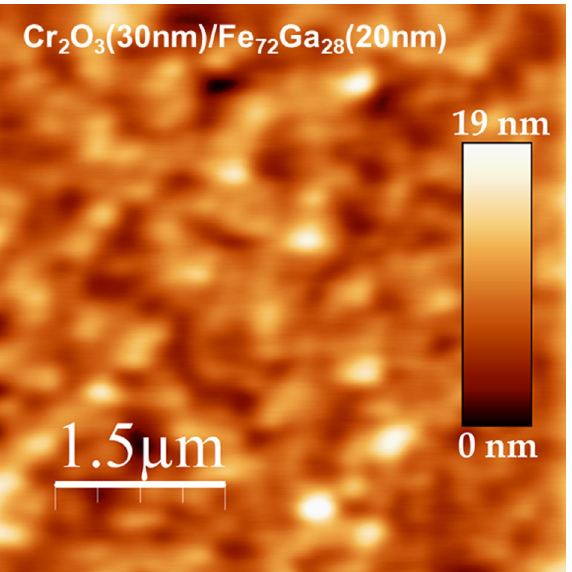
Figure 2. Morphology of the sample Cr 2 O 3 (30 nm)/Fe 72 Ga 28 (20 nm) measured by AFM in an area of 5 μm × 5